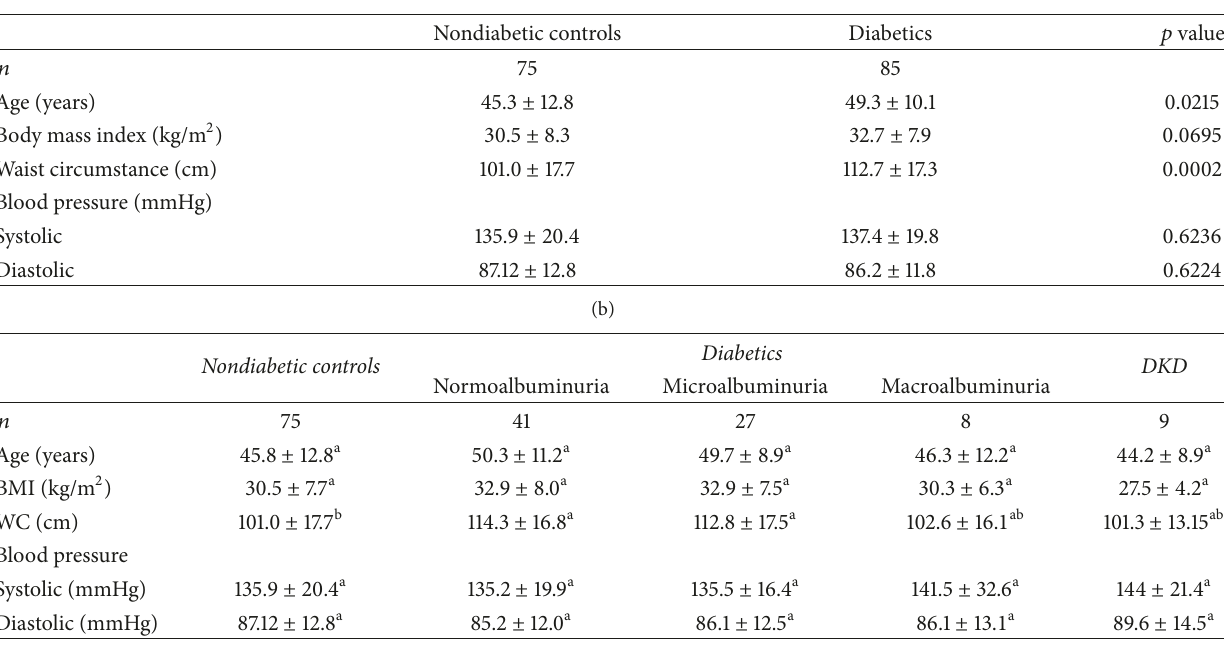
Table 1: Clinical characteristics of subjects. Data are mean ± SD. Note. 𝑝 value is calculated between controls and diabetic patients with or without known kidney disease. Values without a common letter (a, b, or ab) are significantly different.